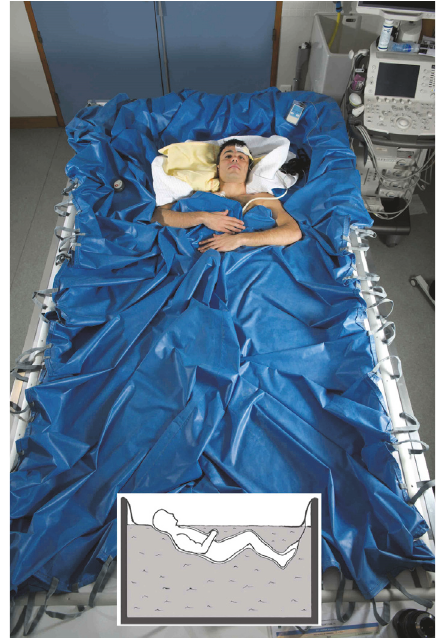
Figure 1: Dry immersion model in MEDES-IMPS Toulouse, France (Source CNES,